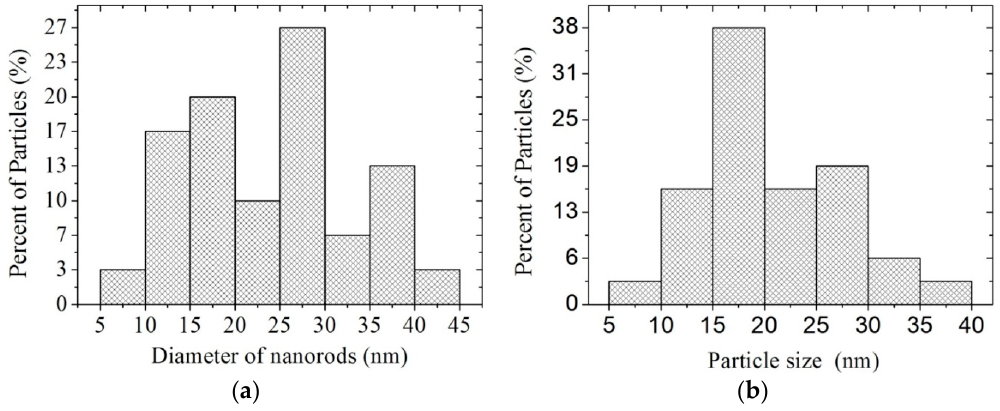
Figure 5. Size distribution of MgSb 2 O 6 : ( a ) nanorods’ diameter; and ( b ) size of nanoparticles.